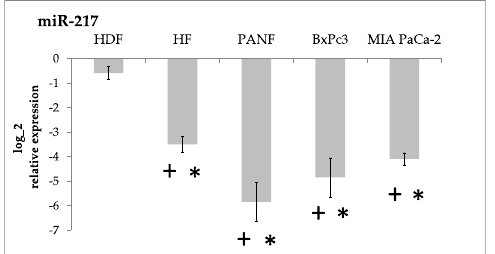
Figure 2. Log2 relative expression intensity of miR-21 and miR-210 in cultured human fibroblasts (HDF and HFs), cancer-associated fibroblasts prepared from pancreatic ductal adenocarcinoma (PANF) and cell lines prepared from this type of tumor (BxPC3 and MIA PaCa-2) compared to the tissue of the normal pancreas. Significant differences between cultured cells and the tissue of the normal pancreas, i.e., two-fold increase at adjusted p -value < 0.05, are marked by asterisks. Statistically significant differences between HDF of ectomesenchymal origin and other cell lines at adjusted p -value < 0.05 are marked by crosses.